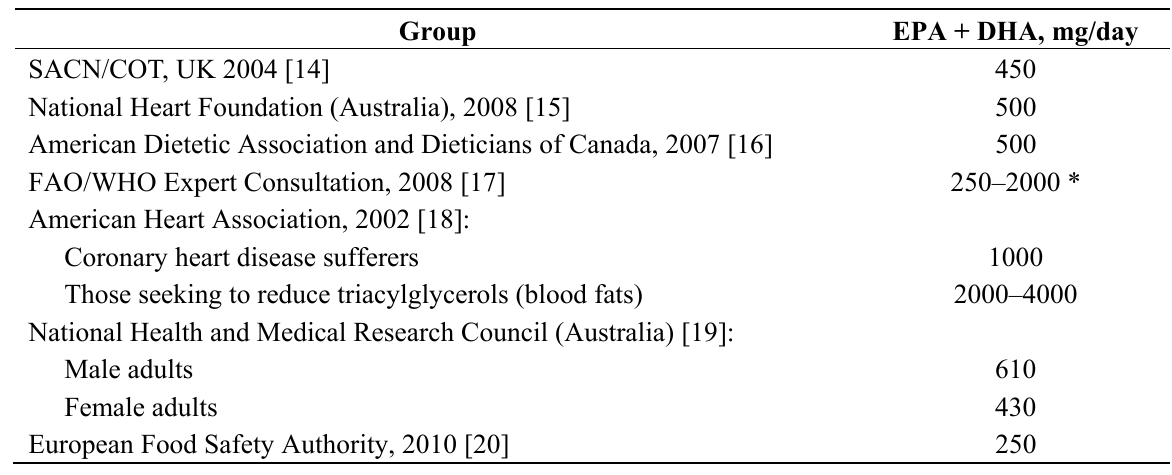
Table 1. Selected suggested long-chain (LC) omega-3 (eicosapentaenoic acid